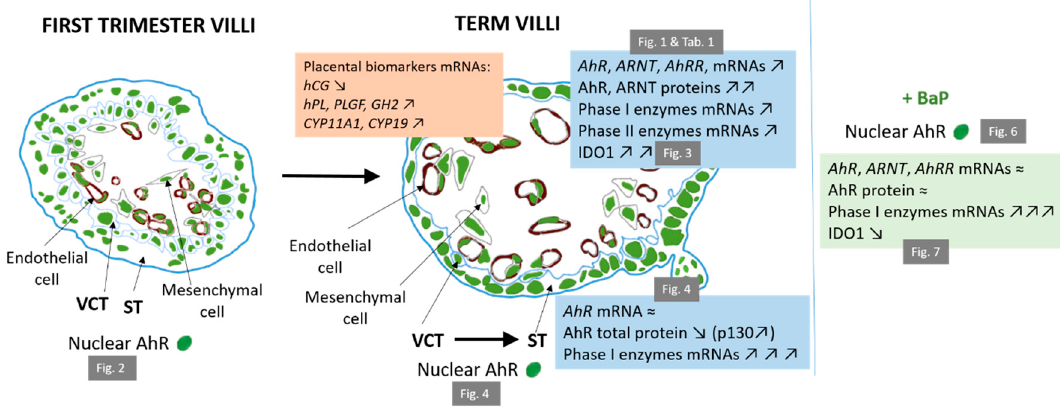
Figure 8. Summary of the results on AhR and relevant biomarkers’ changes during pregnancy. First trimester villi (on the left) evolve into term villi (on the right). Changes in placental biomarkers between the first trimester and term are found in the orange box, and changes in AhR, its partner ARNT, its repressor AhRR, phase I and II enzymes, and IDO1 between first trimester and term are found in the higher blue box. Changes in AhR and phase I enzyme during VCT differentiation into ST are found in the lower blue box. On the right side, changes in AhR, ARNT, AhRR, phase I enzymes, and IDO1 after incubation of BeWo cells or villi explants with 1 µ M BaP are showed. Nuclear localization of AhR in the different cell types is visualized with a green bullet. Increase in a marker is represented by ↗ , decrease by ↘, and no change by ≈ .